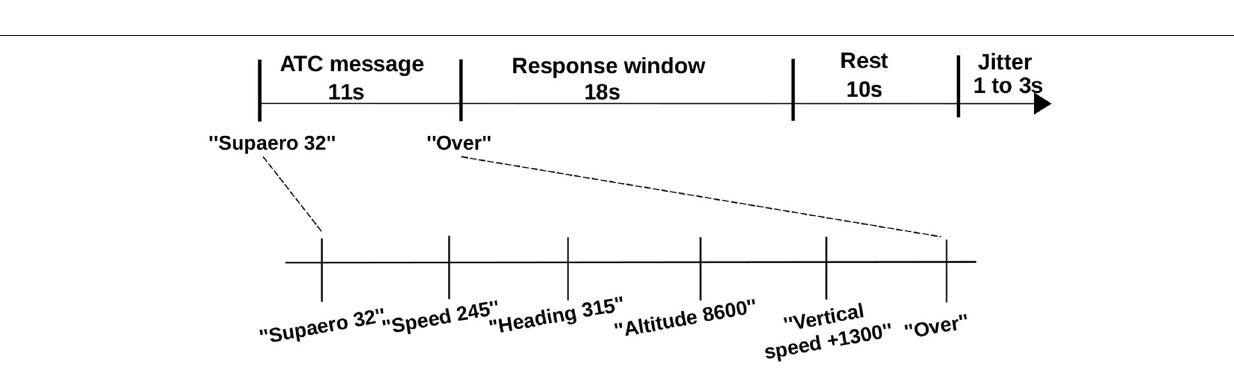
FIGURE 2 | (Left) ISAE-Supaero flight simulator; the closed cabin is visible from rear, and eight screens are used to visualize external environment. (Right) The pilot subject with the fNIRS headband.